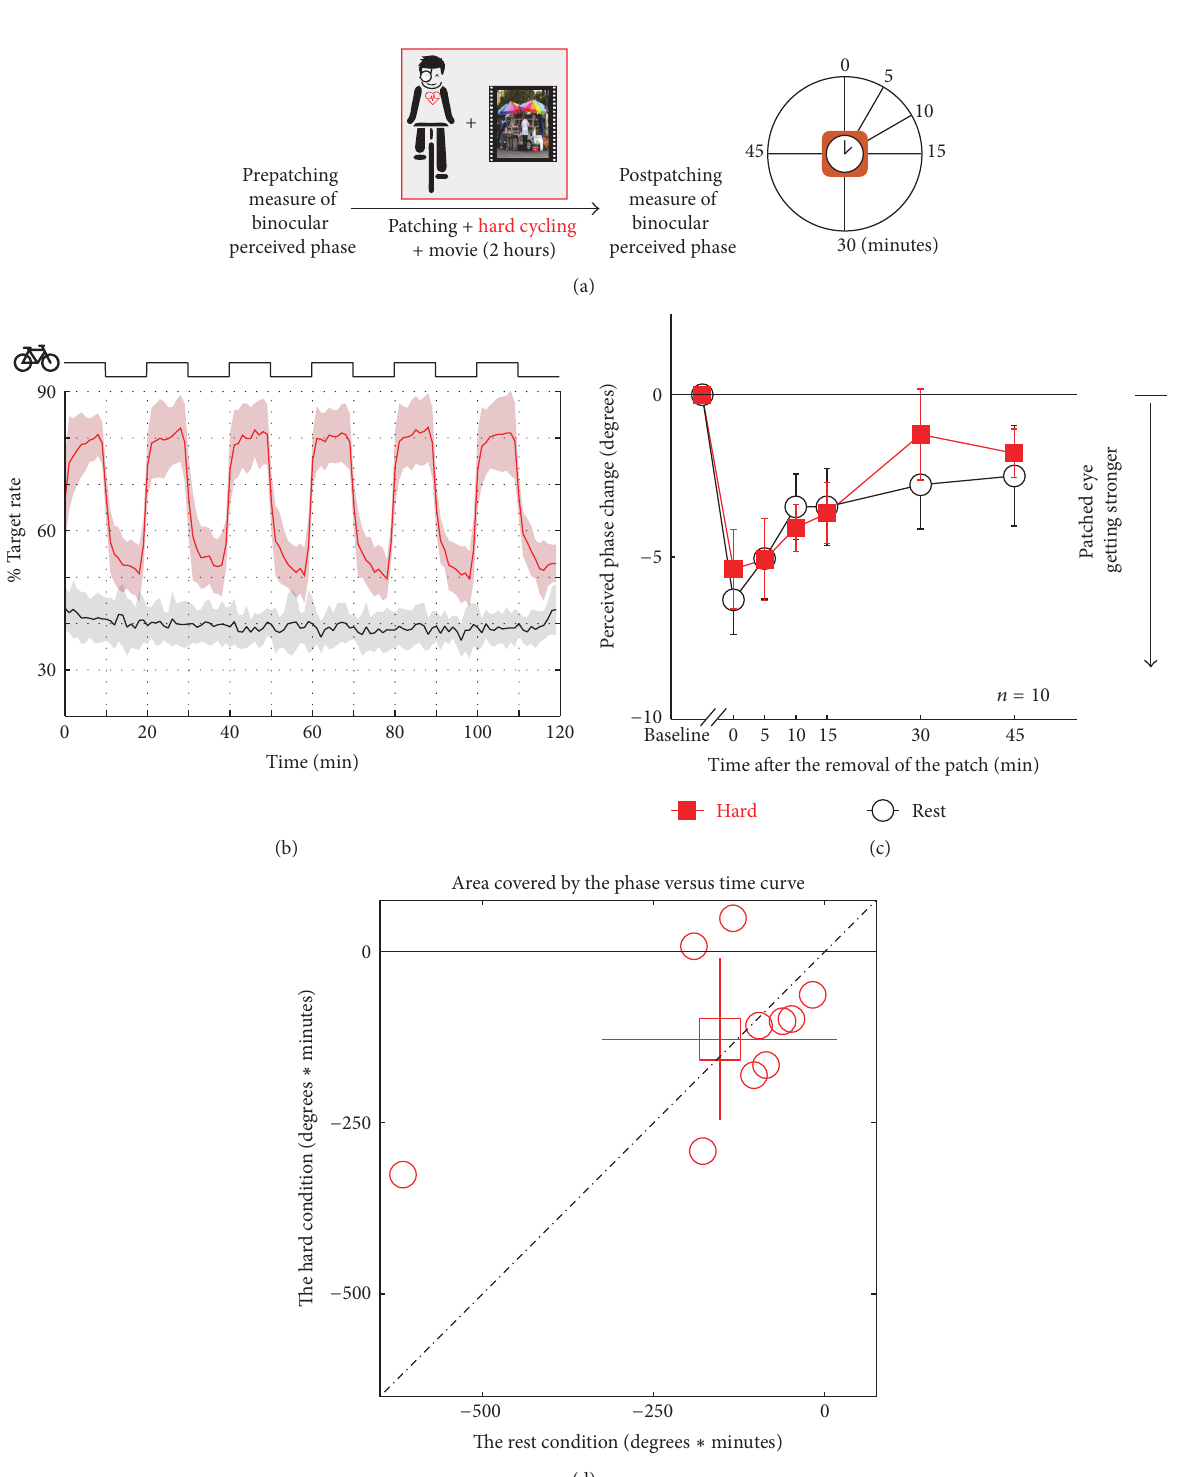
Figure 3: Illustration of the protocol for assessing the effect of severe exercise on ocular dominance plasticity as a result of short-term monocular deprivation. Subjects ( 𝑛 = 10 ) are monocularly patched while cycling (10min cycling, 10 min rest) and watching a movie for 2 hours (a). The exercise raises the heat rate by around 80% of its estimated maximum age-related heart rate (b). The change in ocular dominance as a result of the monocular deprivation is compared for the baseline (resting condition: black lines/open circles) and exercise condition (red lines/filled squares) (c). The computed areal change (degrees × minutes) is compared for each subject at rest and after exercise; the open square symbol is the group mean ± SD